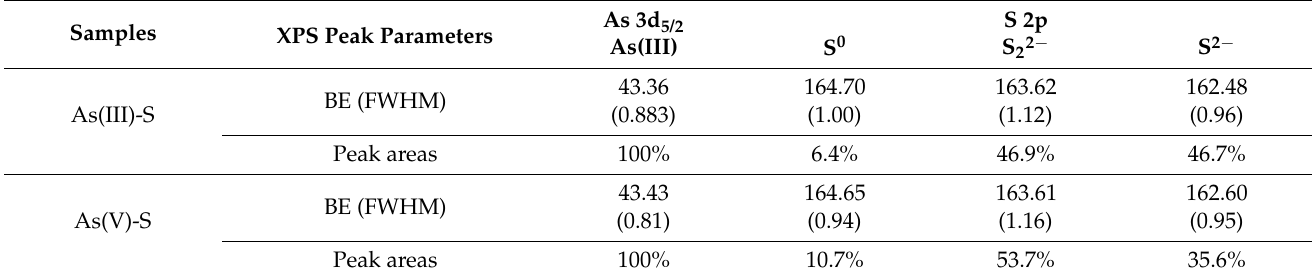
Table 2. Bending energy, FWHM, and peak positions from the XPS spectra of As 3d and S